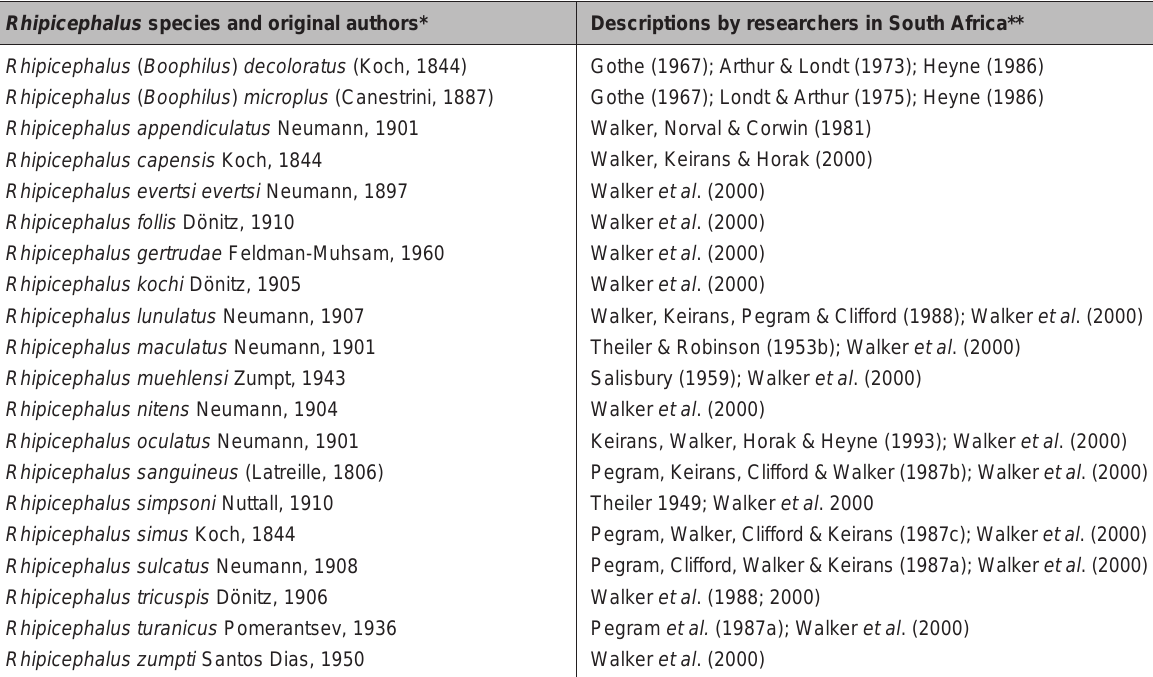
TABLE 4 South African Rhipicephalus species described by foreign researchers, for which additional descriptions have been pro- duced since 1908 by researchers in South Africa Rhipicephalus species and original